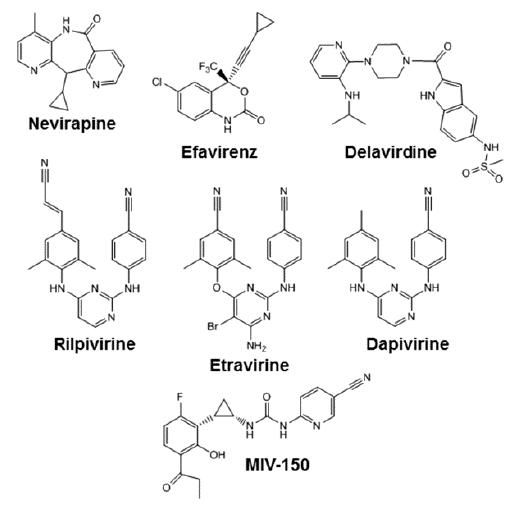
Figure 1. Chemical structures of nonnucleoside reverse transcriptase inhibitors (NNRTIs) used in HIV-1 prevention and treatment